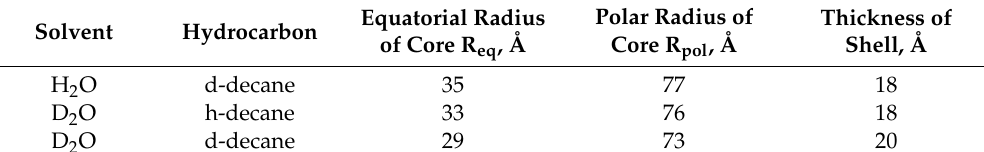
Table 2. Geometrical parameters of elliptical microemulsion droplets formed in 117 mM C8TAB, 78 mM potassium oleate, and 210 mM of n-decane aqueous solutions obtained from SANS data.